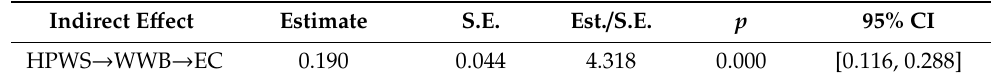
Table 5. Indirect e ff ect of work